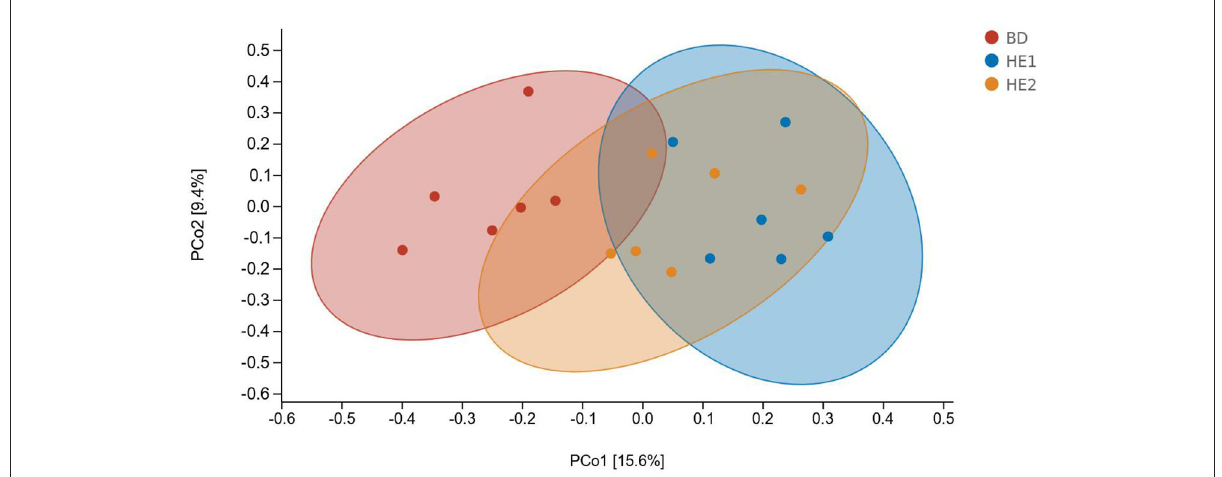
FIGURE5 The PCoA based on the Bray-Curtis